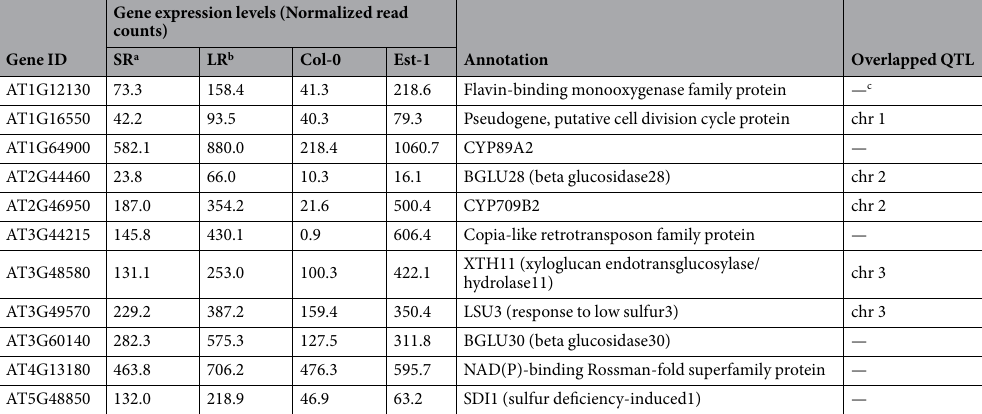
genes related to brassinosteroid (BR) synthesis or signaling [ BEN1 (AT2G45400) 23 , DWF1 (AT3G19820) 24 and